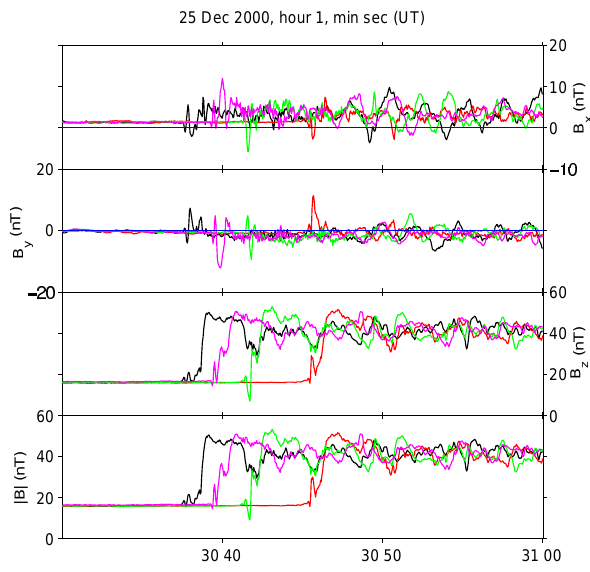
Fig. 6. Four spacecraft observations of a quasi-perpendicular shock. Colours are black, red, green and magenta for spacecraft 1, 2, 3 and 4 respectively. High resolution (22 vector/s) GSE data are shown. Note the different ramp profile at each